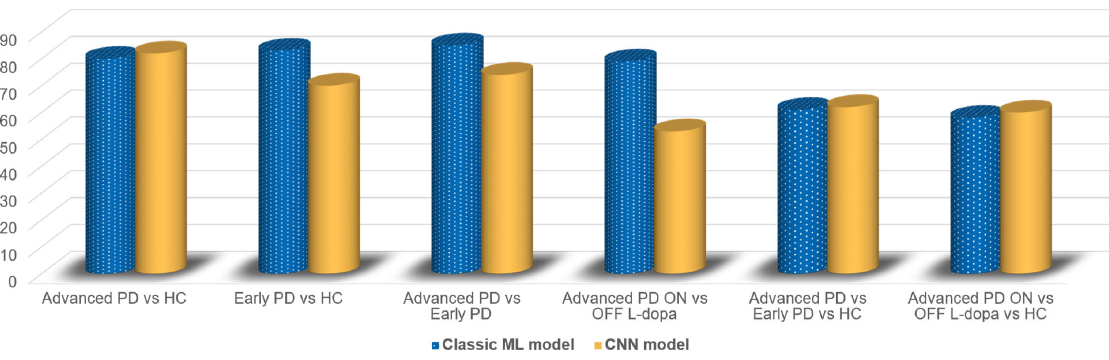
Figure 6. Comparison between the best classic ML model fed with handcrafted features and a CNN model fed with spectrogram images. Results are expressed in terms of CV classification accuracy. L ‐ Dopa therapy ON vs. OFF. Table 6. Binary classification performance of the best traditional ML and CNN models. Results are reported in terms of CV accuracy. Acc: accuracy; PPV: positive predictive value; NPV: negative predictive value; Sen: sensitivity; Spec: specificity; AUC: area under the curve. 1. Mid ‐ Advanced PD vs. HC